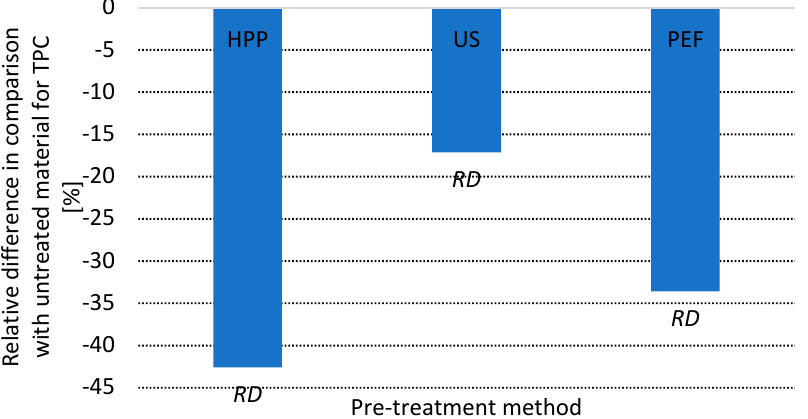
Figure 4. Relative total phenolic content (TPC) in dried apples, pretreated by different methods and calculated in comparison with untreated dried samples. RD indicates statistically significant difference, NRD indicates statistically non-significant difference in comparison with untreated dried material (Student’s t test, α = 0.05).